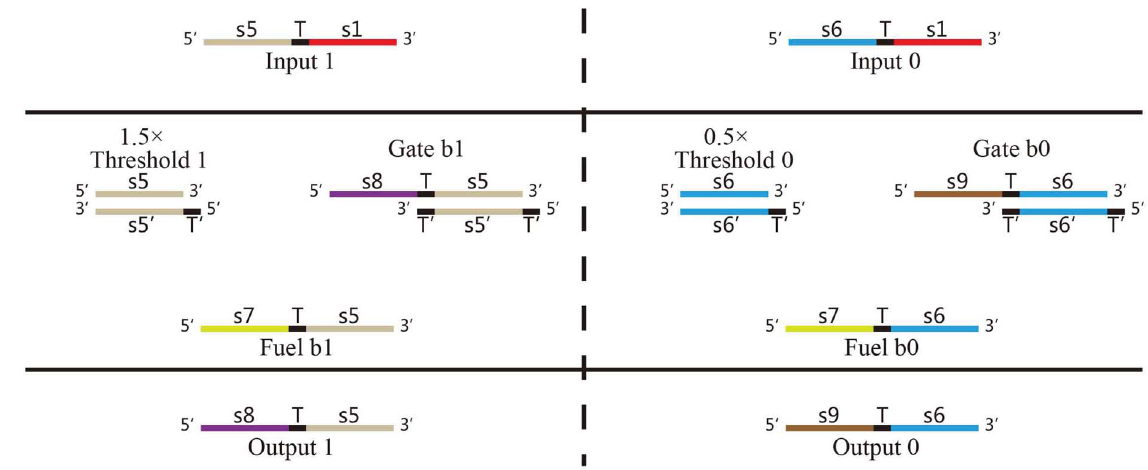
Figure 3. Abstract diagrams of implementation of a DNA neuron with AND logic.